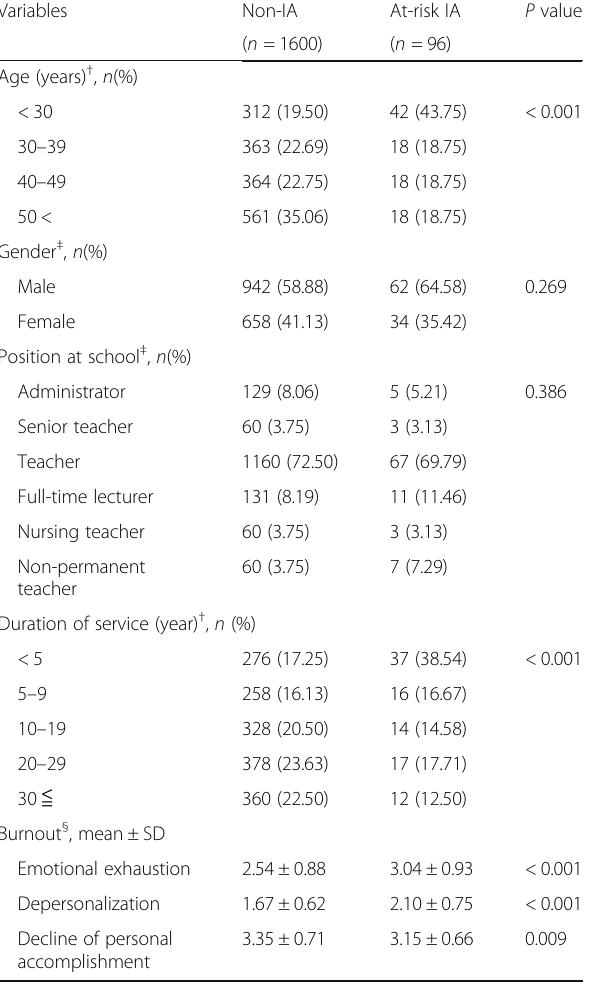
Table 2 Comparisons of internet usage between at-risk IA and non-IA Variable Non-IA At-risk